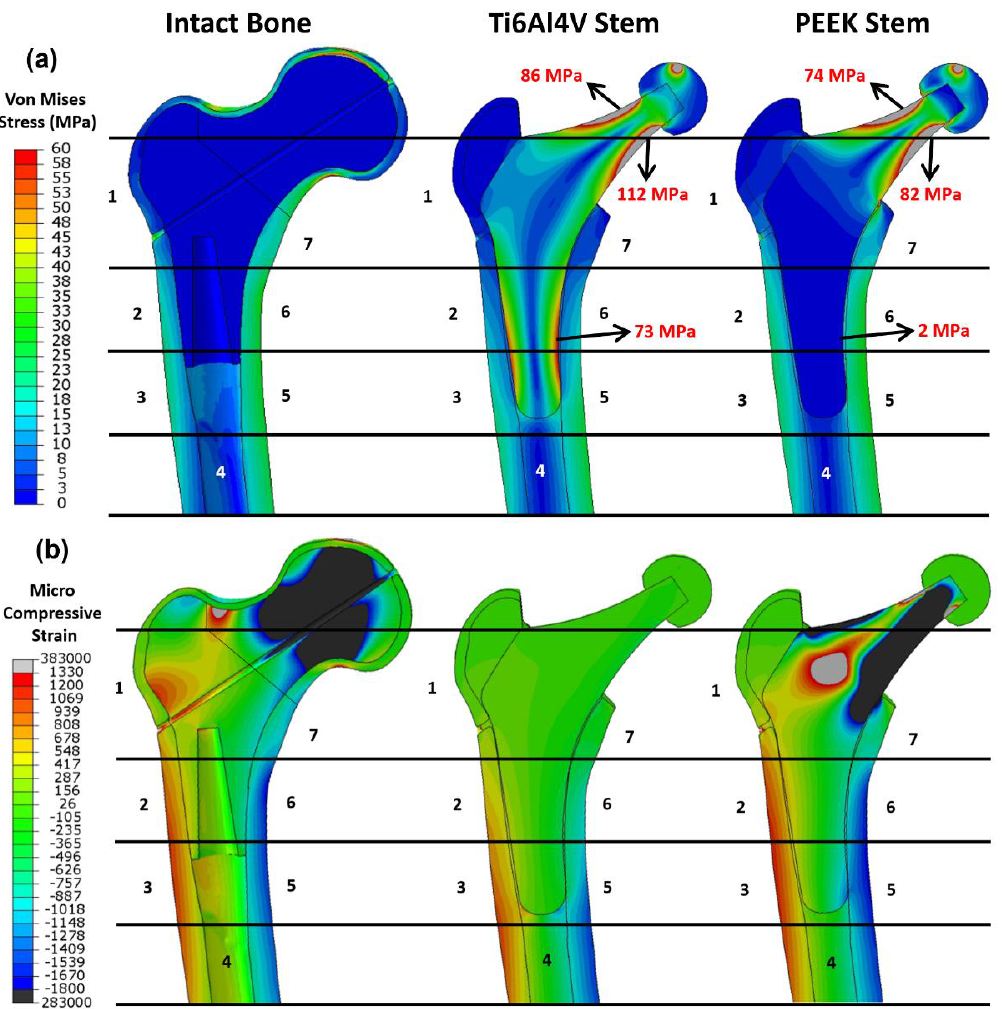
Figure 9. Distribution of the (a) von Mises stress and (b) the compressive strain for the intact bone, the femur with the Ti6Al4V stem, and the femur with the PEEK stem. The numbers indicate the Gruen zones 1 –